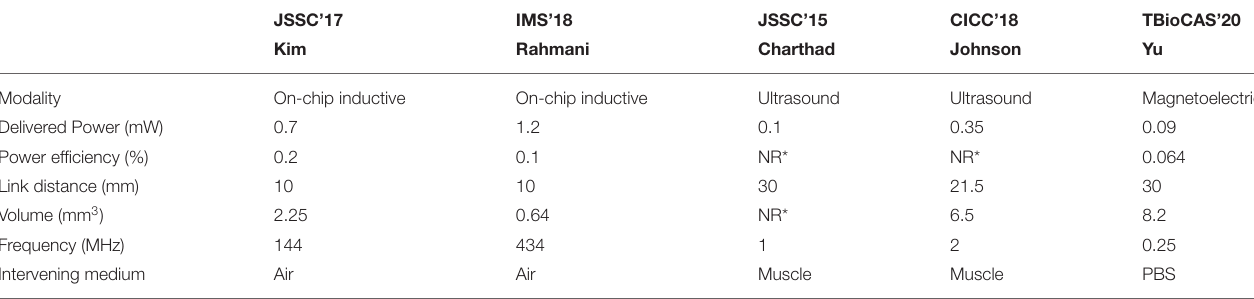
TABLE 3 | Comparison table of the state of the arts